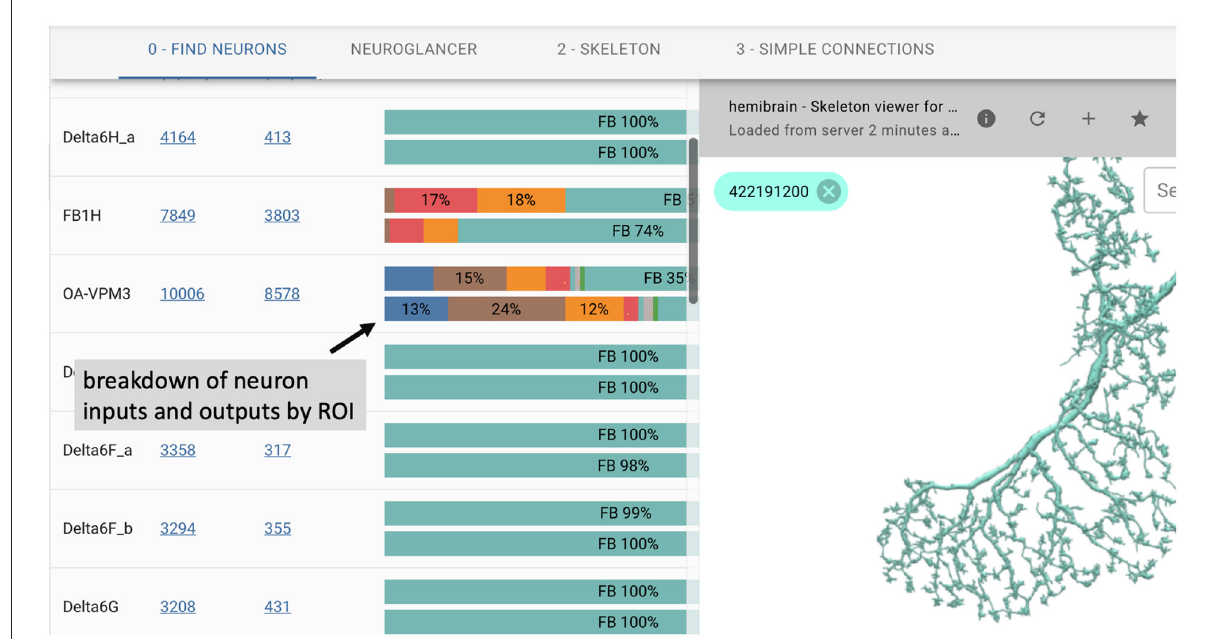
FIGURE3 neuPrintExplorer web application. Queries generate tables of results. Visualizations exist to see 3D neurons and to help break down the complexity of the